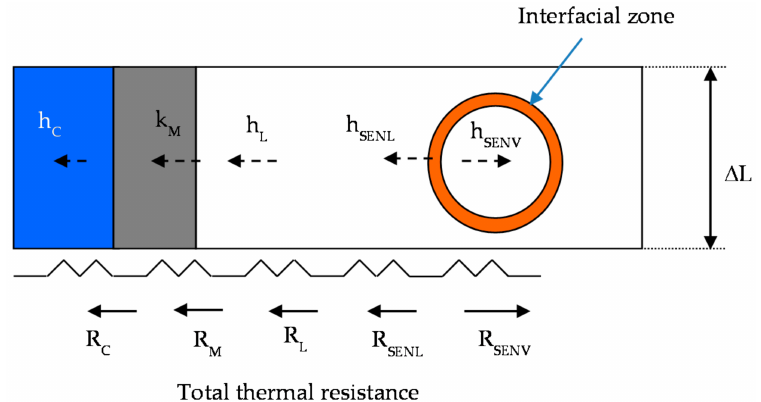
Figure 5. Thermal resistance from vapor phase to cooling